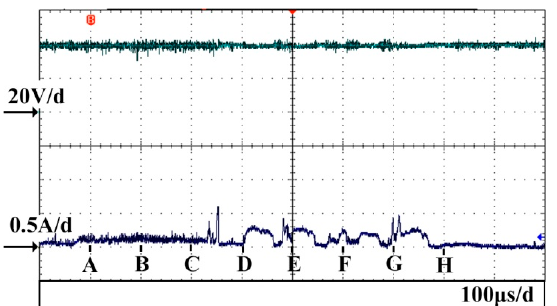
Micromachines 2023 , 13 , x FOR PEER REVIEW Figure 5. Voltage and current waveforms during the discharge stage. Figure 5. Voltage and current waveforms during the discharge stage.